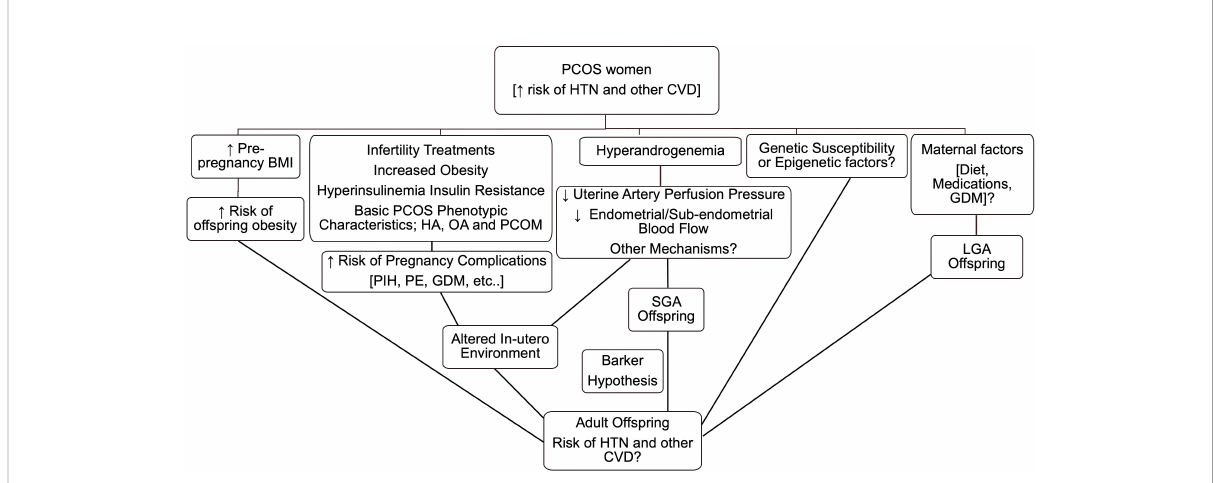
FIGURE 1 Rationale and possible mechanisms behind increased risk of hypertension (HTN) and other cardiovascular diseases (CVD) in offspring of polycystic ovary syndrome (PCOS) women. BMI, body mass index; HA, hyperandrogenism; OA, oligo- or an-ovulation; PCOM, polycystic ovarian morphology; GDM, gestational diabetes mellitus; PIH, pregnancy-induced hypertension; PE, pre-eclampsia; LGA, large-for-gestational age; SGA, small-for-gestational